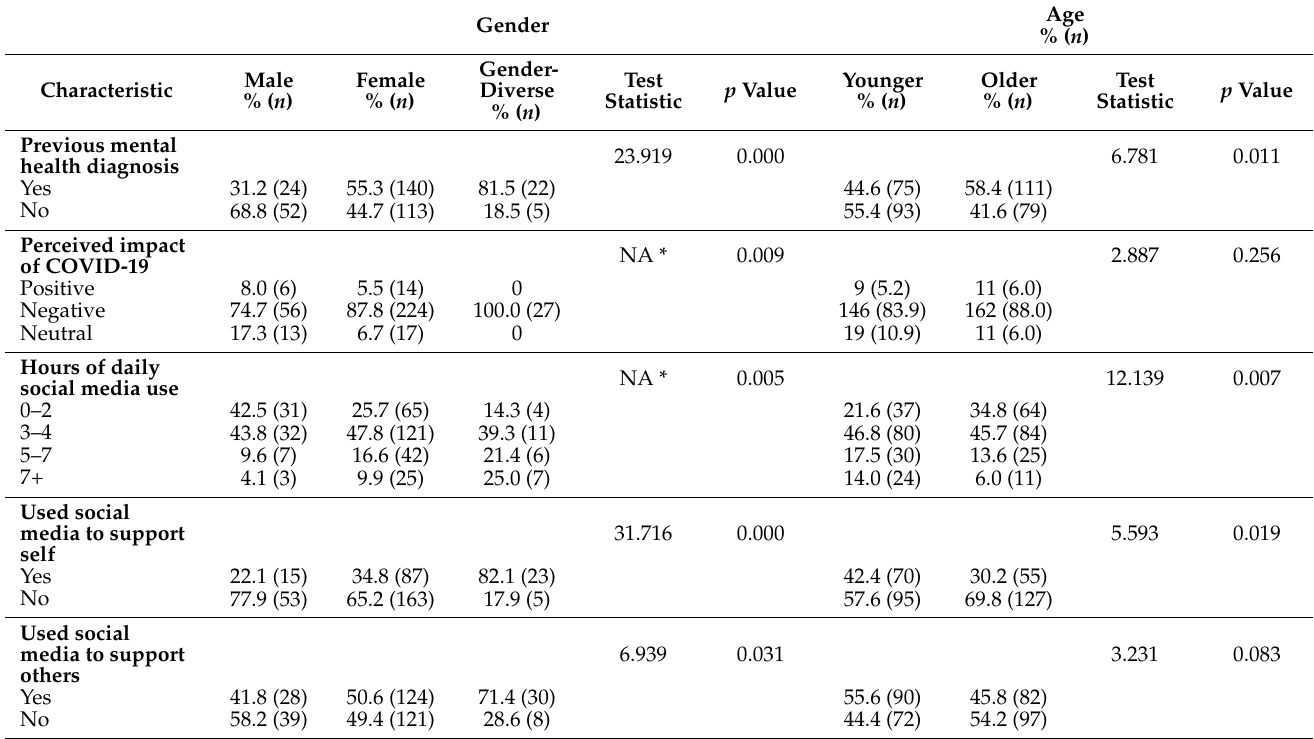
Table 2. Chi-square tests of independence examining gender and age differences for categorical variables.